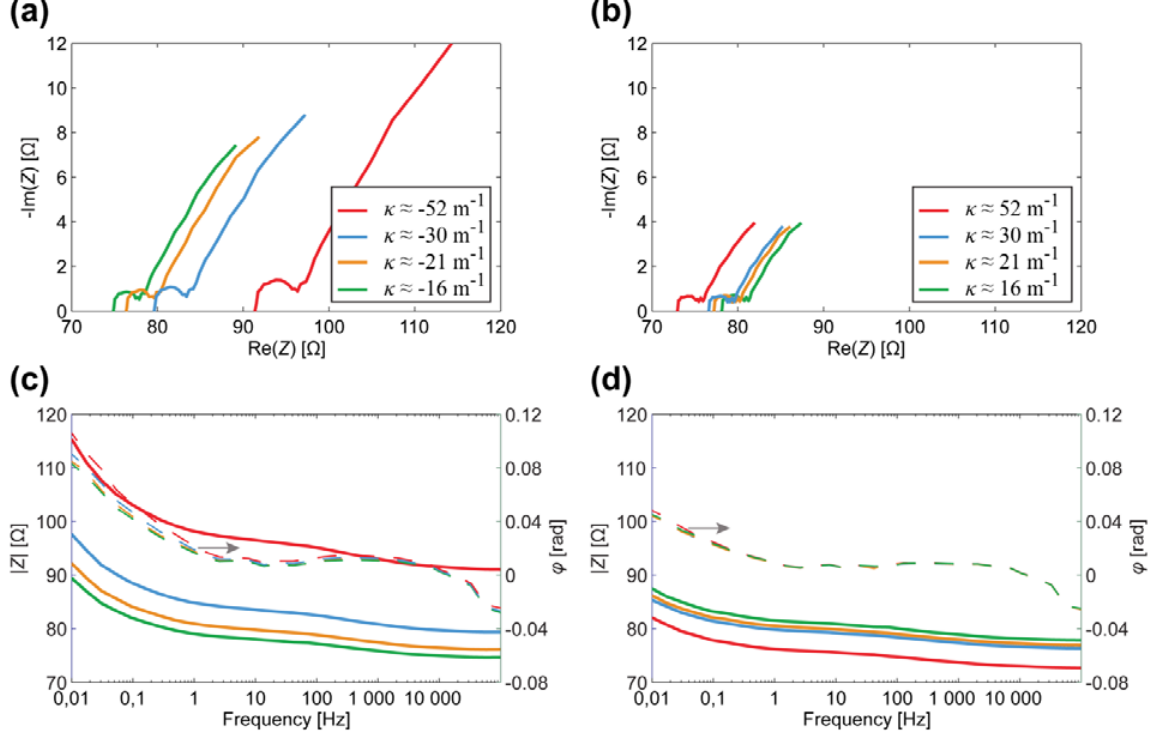
Figure 7. The correlation between the surface electrode impedance and the curvature of a CPC actuator. ( a ) Nyquist plot for convex surface electrode; ( b ) Nyquist plot for concave surface electrode; ( c ) Bode plot for convex surface electrode; ( d ) Bode plot for concave surface electrode.